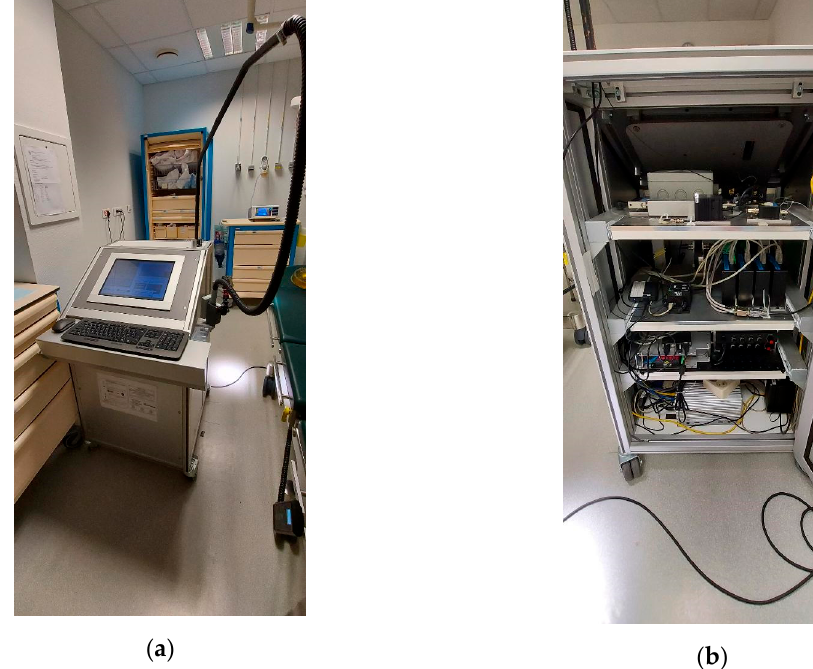
Figure 3. SpectroLive device in a surgery room at the Metz-Thionville regional hospital. ( a ) Front view showing tactile screen, keyboard, the pole holding the optical fiber probe and its holder (right side). ( b ) Back view: top shelf, light sources; second shelf, spectrometers and filters wheel; 3rd shelf, LEDs controllers; bottom shelf, computer central unit and electrical filter.